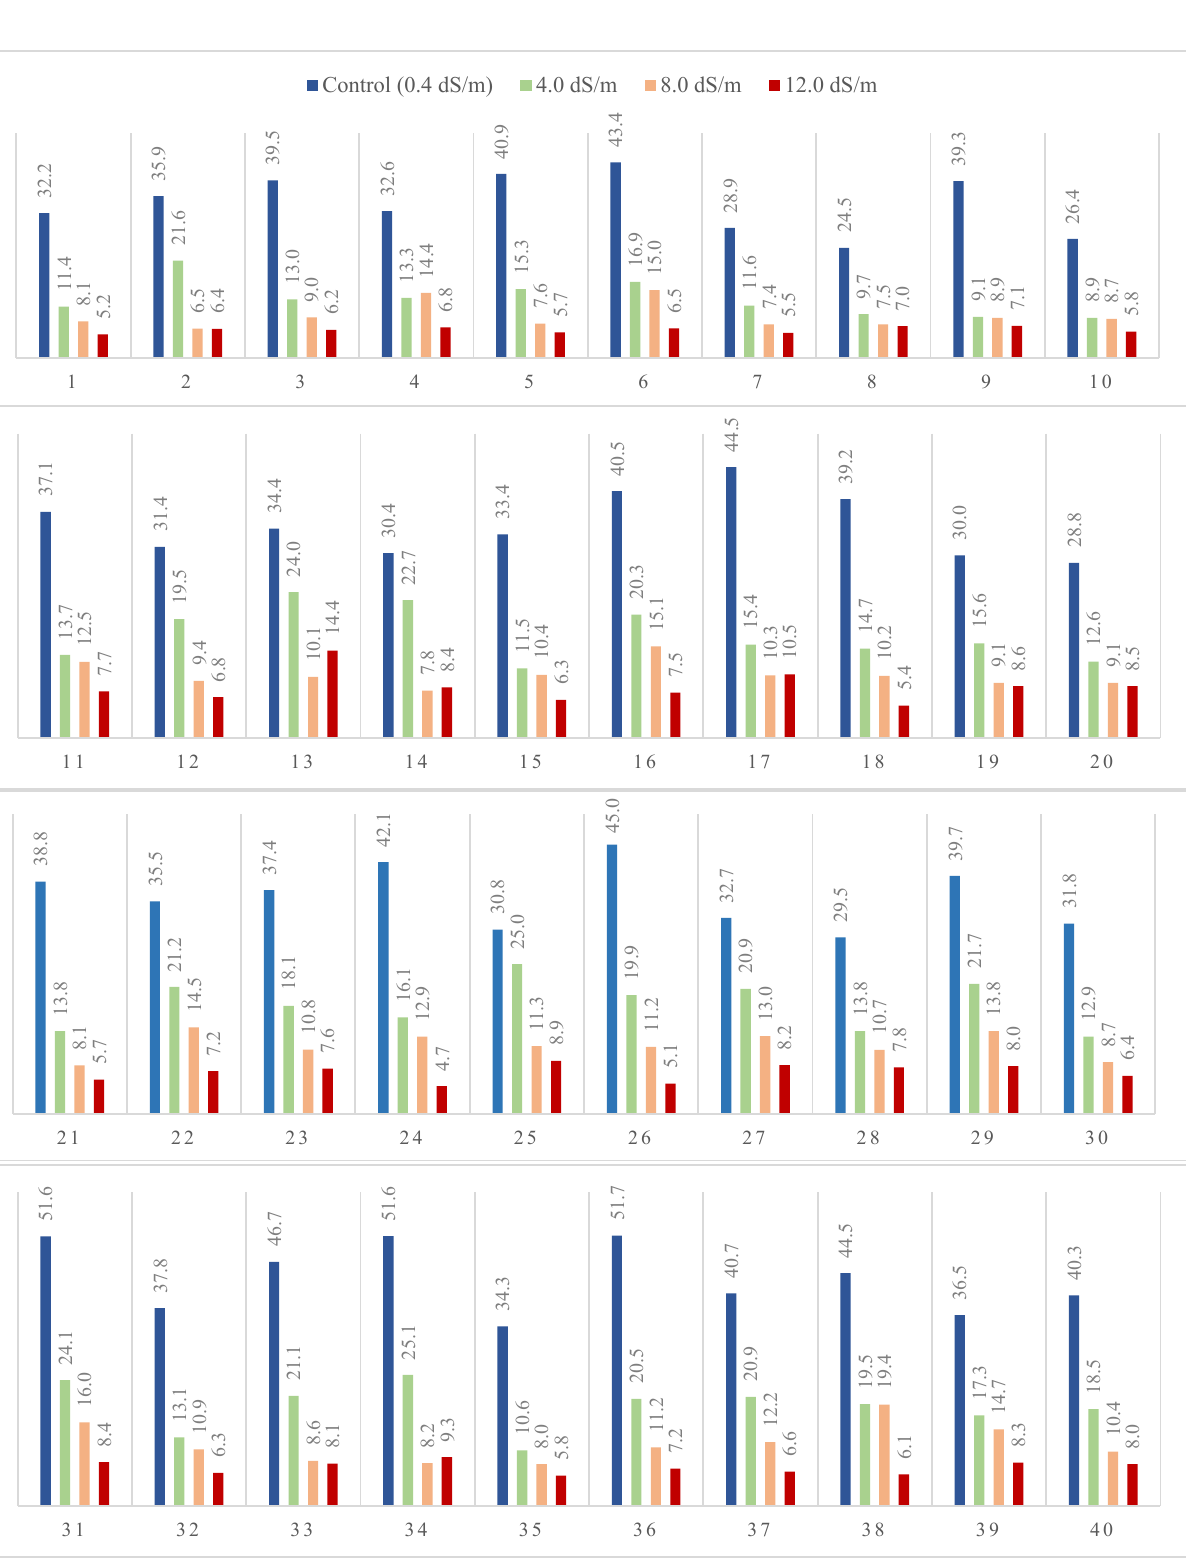
Figure 2. Wheat grain yield gm per pot (GY) of forty genotypes evaluated in pot and grown under 0.4, 4.0, 8.0, or 12.0 dS/m of seawater in the 2019/20 season.